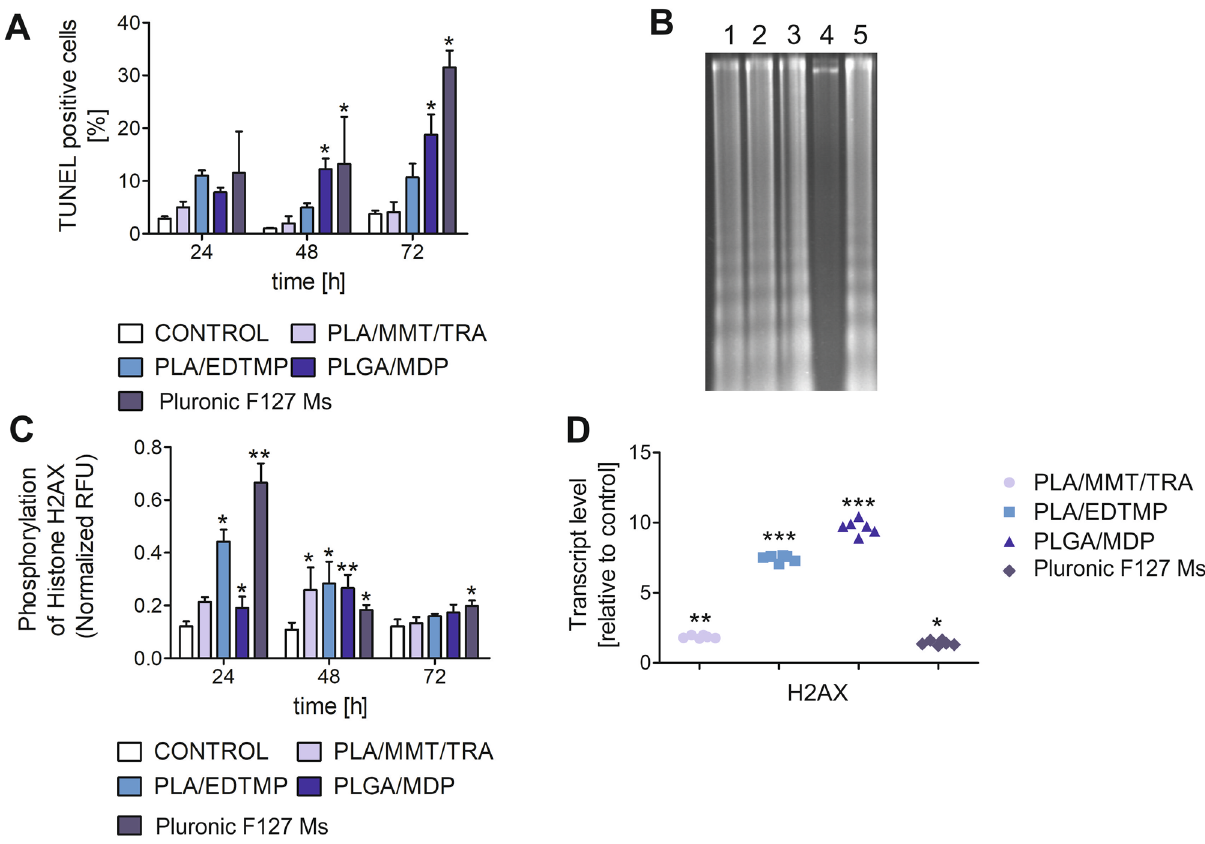
Figure 4. DNA damage in HUVEC-STs triggered by NPs is the result of apoptosis. ( A ) Induction of apoptosis- dependent DNA fragmentation in HUVEC-STs after treatment with NPs [PLA/MMT/TRA, PLA/EDTMP, PLGA/MDP (100 μg/mL), or Pluronic F127 Ms (0.25 μg/mL)] at 24, 48, and 72 h estimated by the TUNEL assay. Results represent the mean ± SD of three independent experiments. *p < 0.05 for significant differences between NP-treated and control cells. ( B ) DNA fragmentation induced by NPs detected by agarose gel electrophoresis of DNA isolated from human endothelial cells. HUVEC-STs were treated for up to 72 h with 100 μg/mL of PLA/EDTMP, PLGA/MDP, and PLA/MMT/TRA or 0.025 μg/mL of Pluronic F127 Ms; 1—PLA/ MMT/TRA, 2—PLA/EDTMP, 3—PLGA/MDP, 4—Control, 5—Pluronic F127 Ms. ( C ) NP effect (100 μg/mL of PLA/EDTMP, PLGA/MDP, and PLA/MMT/TRA or 0.025 μg/mL of Pluronic F127 Ms) on histone H2AX phosphorylation in human endothelial cells. *p < 0.05, **p < 0.01 for significant differences between NP-treated and control cells. Data are the means ± SD of three independent experiments. ( D ) Level of mRNA transcripts for histone H2AX gene in HUVEC-STs exposed to NPs (100 μg/mL of PLA/EDTMP, PLGA/MDP, and PLA/MMT/ TRA or 0.025 μg/mL of Pluronic F127 Ms) for 24 h. Data are expressed as the means ± SD, (n = 3). Asterisks refer to level of significant (*p < 0.05, ***p < 0.001) difference in mRNA level in NP-treated cells compared to untreated control